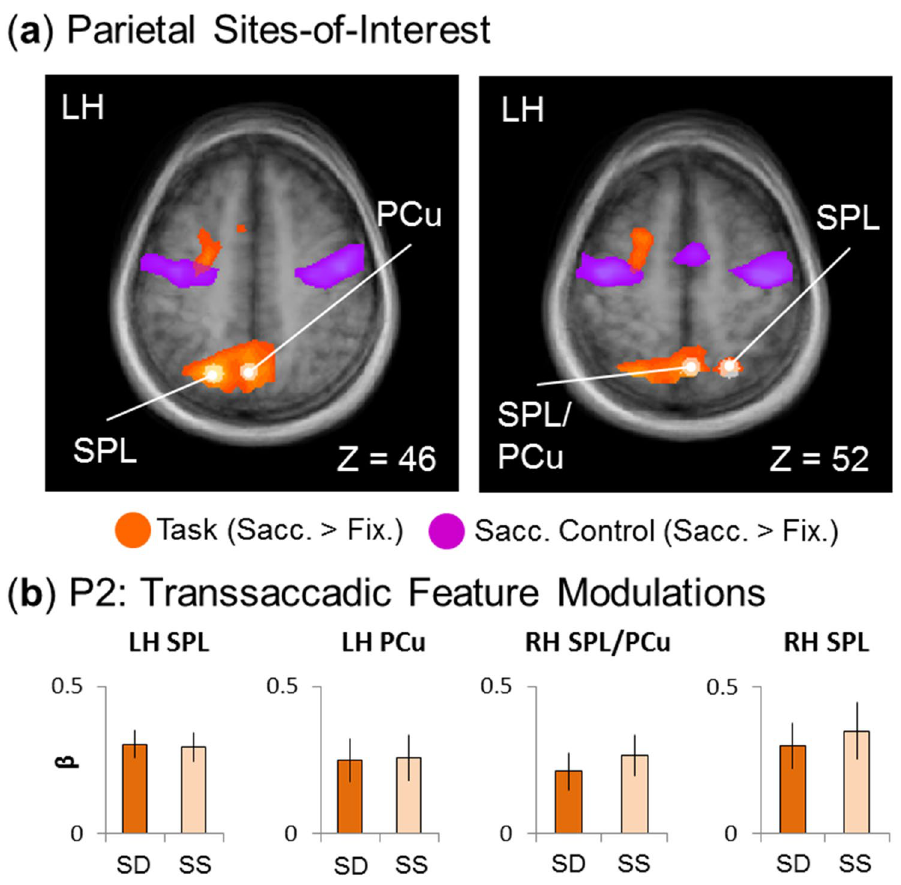
Figure 5. Testing feature specificity in parietal sites-of-interest. ( a ) The sites-of-interest within the parietal cortex were localized, the peak voxels of which are visualized in the transverse slices through the average brain of all (n = 15) participants via the white dots. (These regions are superimposed onto activation maps from an RFX GLM for the experimental transsaccadic data (n = 15; orange) and from the separate saccade control task (n = 12; fuchsia) (BrainVoyager QX v2.8; www. brain voyag er. com).) Spheres (radius = 5 mm) were created around the peak voxels and β-weights were then extracted and tested. The specific regions were centred on left superior parietal lobule (SPL), left precuneus (PCu), a region in right hemisphere spanning across SPL and PCu (SPL/ PCu), and right SPL. ( b ) Feature specificity (Fig. 2, prediction 2a) was tested within the parietal